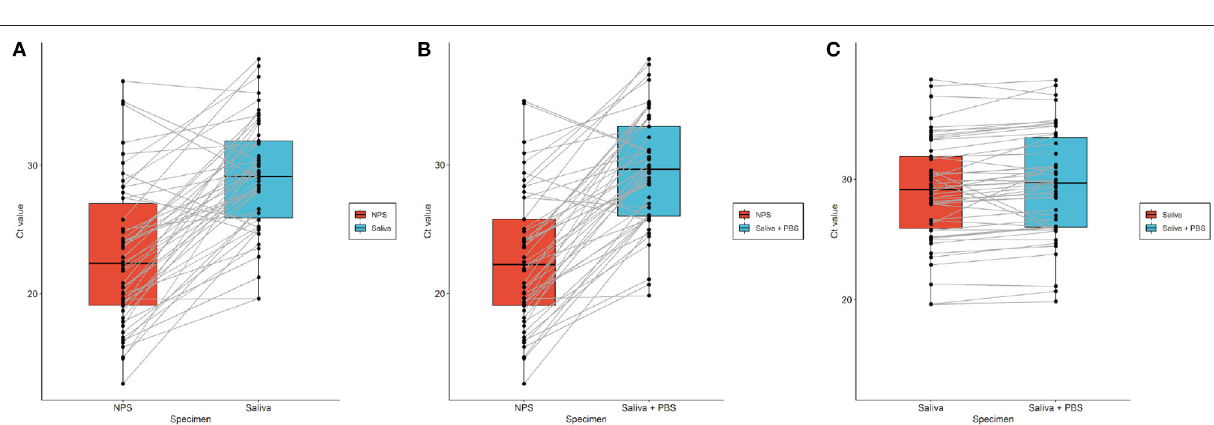
FIGURE 2 | Density chart for cycle threshold (Ct) values from nasopharyngeal swab (NPS) and Saliva specimens (A) ; NPS and Saliva + phosphate-buffered saline (PBS) specimens (B) ; Saliva and Saliva + PBS specimens (C) . This plot compares Ct value distributions by means of smoothed density estimates (kernel density estimates).